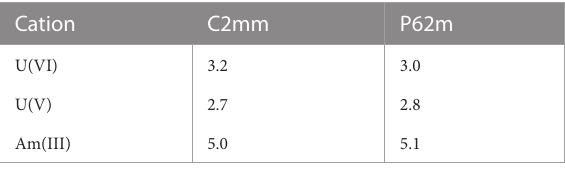
TABLE5 TheHubbard U parametersderivedforAmdopedU 3 O 8 compounds.ThevaluesaregivenineV.